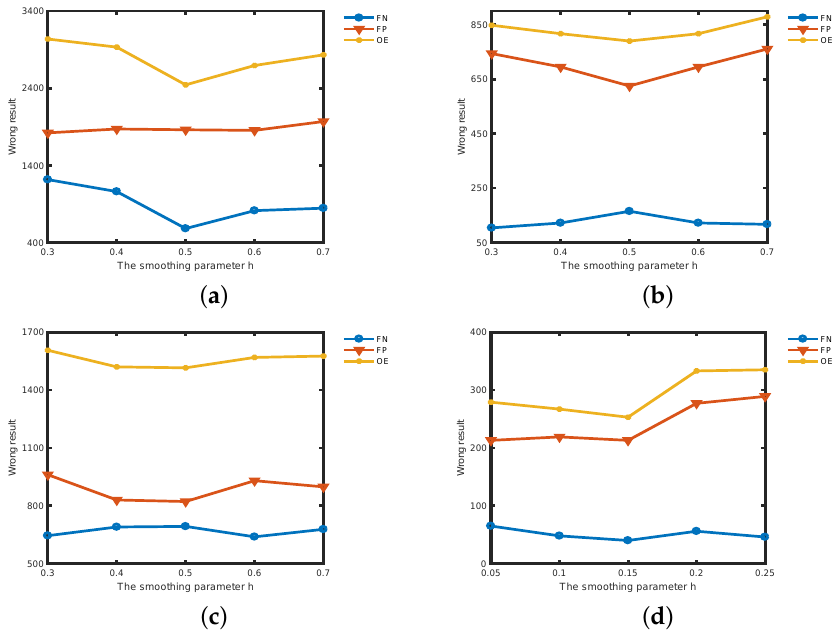
Figure 21. The wrong results on the smoothing parameter in the non-local mean algorithm of four types of data. ( a ) Farmland D data set. ( b ) Farmland C data set. ( c ) Inland water data set. ( d ) Coastline data